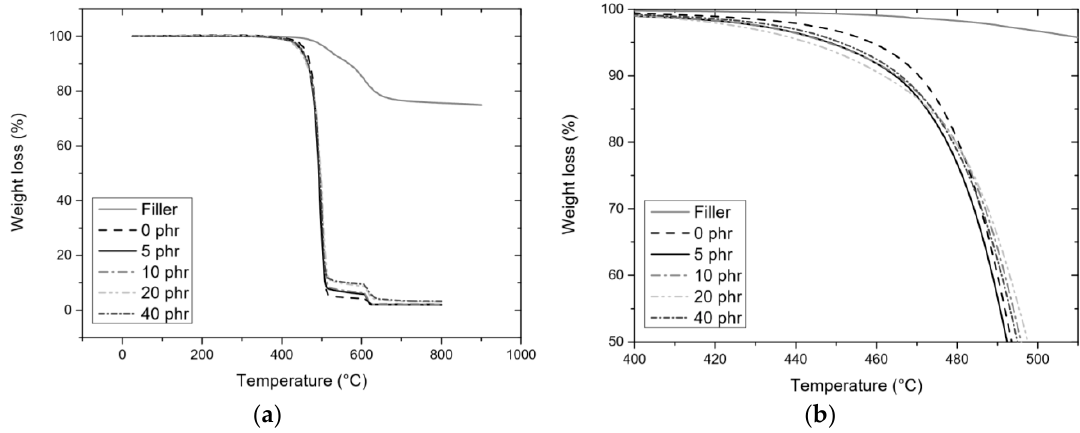
Figure 8. Thermal Gravimetric Analysis (TGA) curves of POSS-P filler and F TP nanocomposites at different filler loading under nitrogen. ( a ) unzoomed; ( b ) zoomed.